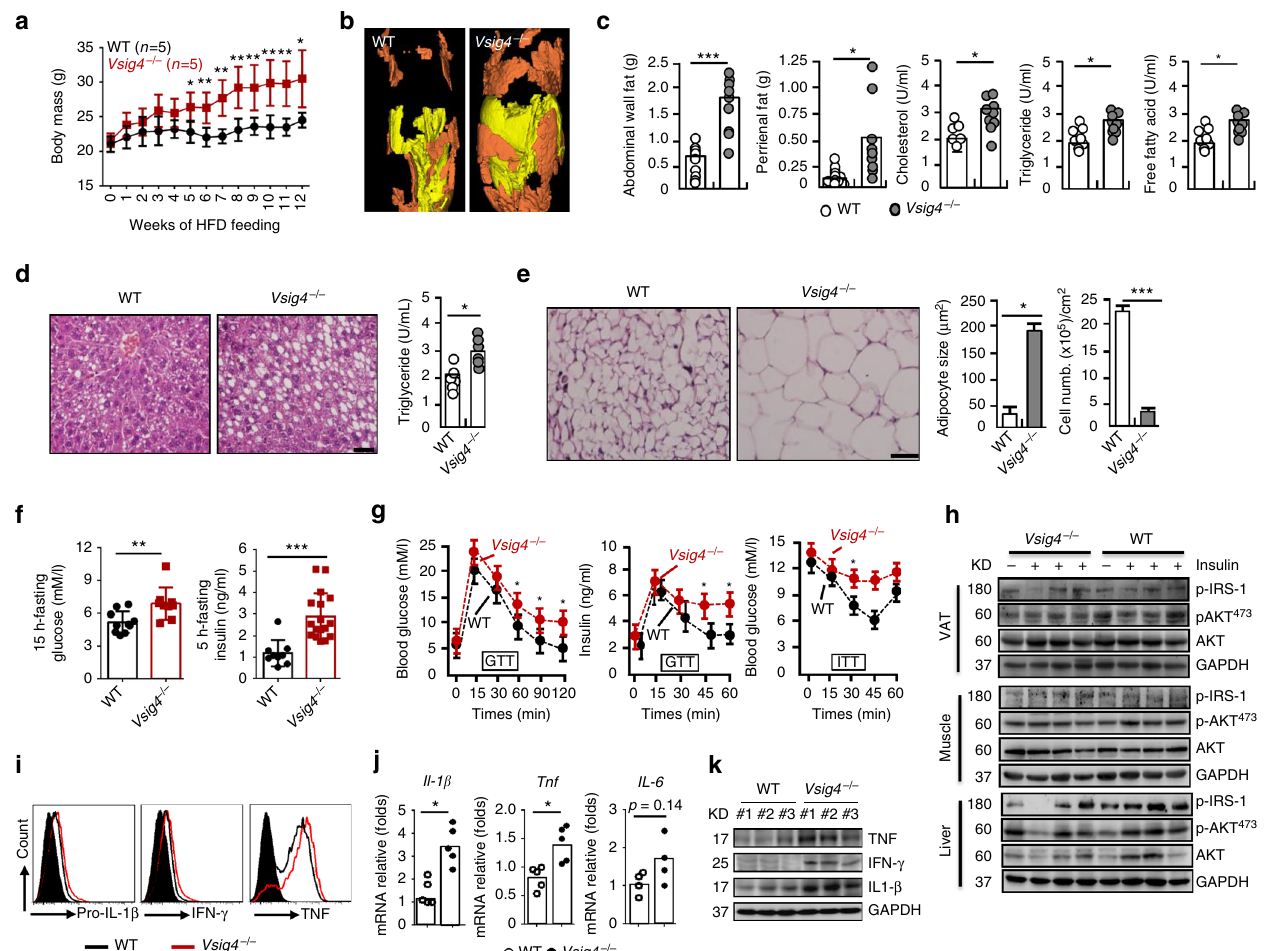
Fig. 1 Vsig4 − / − mice are more susceptible to HFD-induced obesity with insulin resistance. Eight-week-old male Vsig4 − / − mice and age-matched C57BL/6 WT controls were fed a HFD. a Body weight was measured and compared. The obese mice were sacri fi ced after 10 weeks of HFD feeding. b Fat distribution was detected by μ CT. Yellow indicates subcutaneous fat and brown indicates that visceral fat. c Measurement of abdominal wall fat, perirenal fat, serum triglyceride, cholesterol, and free fatty acid. d Representative liver H&E staining (left), and intrahepatic triglyceride contents (right), scale bar = 20 μ m, n = 10 per group. e Representative the architecture of adipose tissues stained by H&E (left), adipocyte size and cell numbers was calculated (right), scale bar = 20 μ m, n = 10 per group. f The 15-h-fasting blood glucose levels and 5-h-fasting serum insulin levels. g GTT and ITT were performed in theses obese mice, n = 6 per group. h Western blot of the AKT, p-Akt ser473 , and p-IRS-1 in VAT, muscle and liver tissues of obese mice after 4 min of insulin administration, n = 4 per group. ATMs were isolated from obese mice. i Flow cytometry analyzing pro-IL-1 β , IFN- γ , and TNF. Cytokines in VAT were detected by j qRT-PCR and k western blot. Error bar, s.e.m. * p < 0.05, ** p < 0.01 and *** p < 0.001 (Student ’ s t -test). Data are representative of fi ve ( a ) and three ( c – i